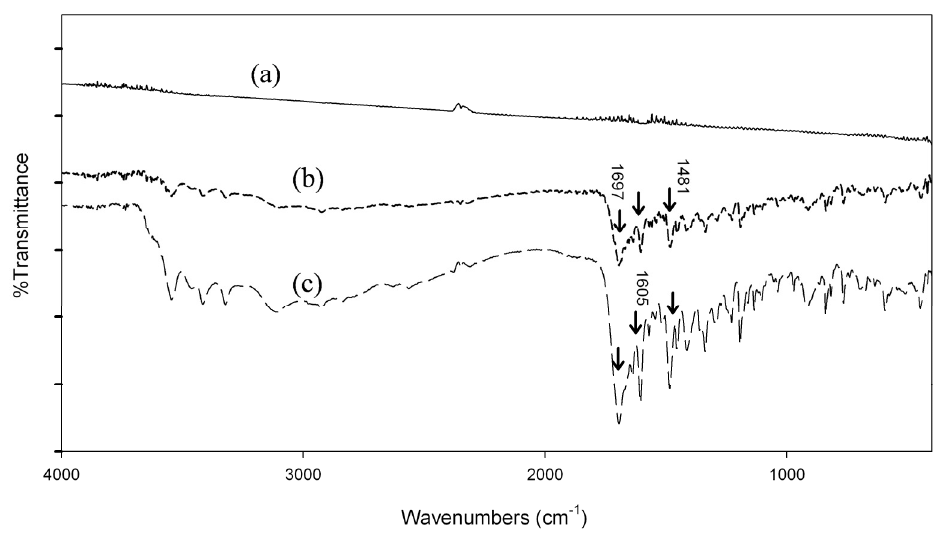
Figure 2. FTIR spectra of (a) naked GNPs, (b) surface-modified GNPs with 2-mercapto- ethylamine and folic acid, and (c) pure folic